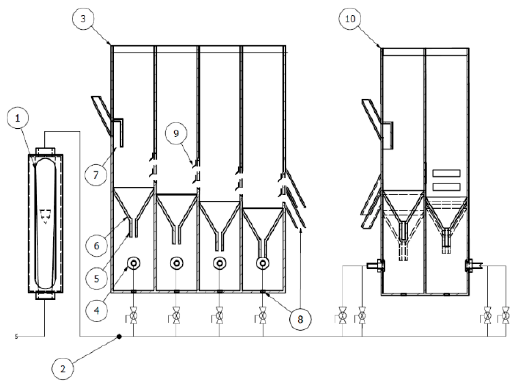
Figure 2. The layouts of the two multi-spouted units: 1—flowmeter; 2—air line and regulation valves; 3—experimental unit 1 × 4; 4—lower air inlet; 5—upper air inlet; 6—pyramid frustum; 7—solid inlet and distributor box; 8—solid outlet; 9—overflow plate; 10—experimental unit 2 × 2.